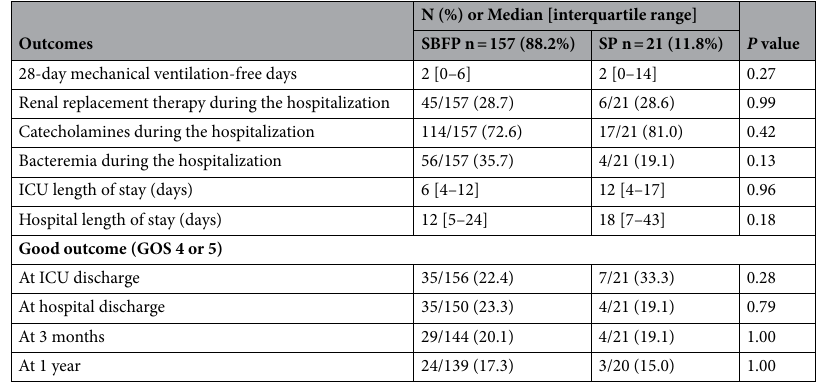
Table 4. Outcomes of 178 critically ill patients with cirrhosis and spontaneous bacterial/fungal peritonitis (SBFP) or secondary peritonitis. SBFP spontaneous bacterial/fungal peritonitis, SP secondary peritonitis, ICU Intensive Care Unit, GOS Glasgow Outcome